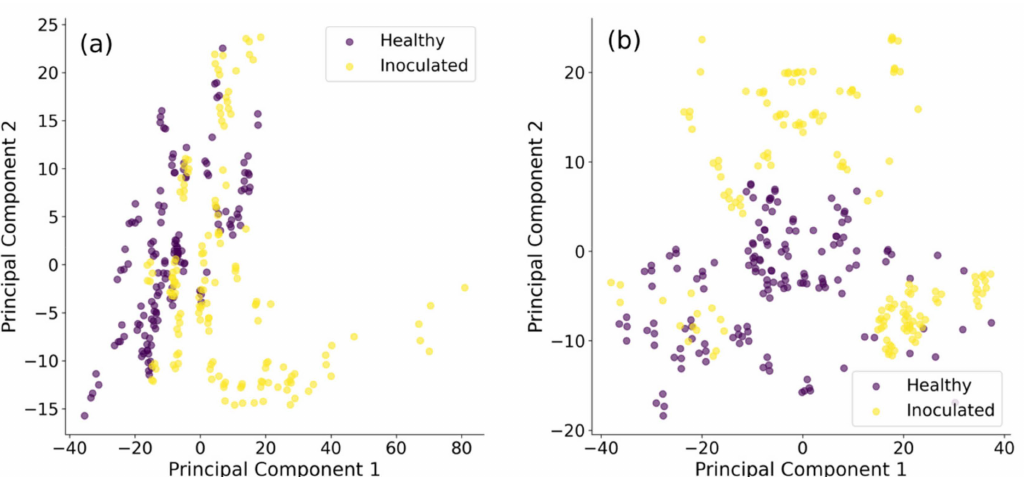
Figure 5. Scatter plot of first two principal components for ( a ) inside and ( b ) outside of potato tubers. Yellow colour refers to healthy and purple colour to inoculated specimens.